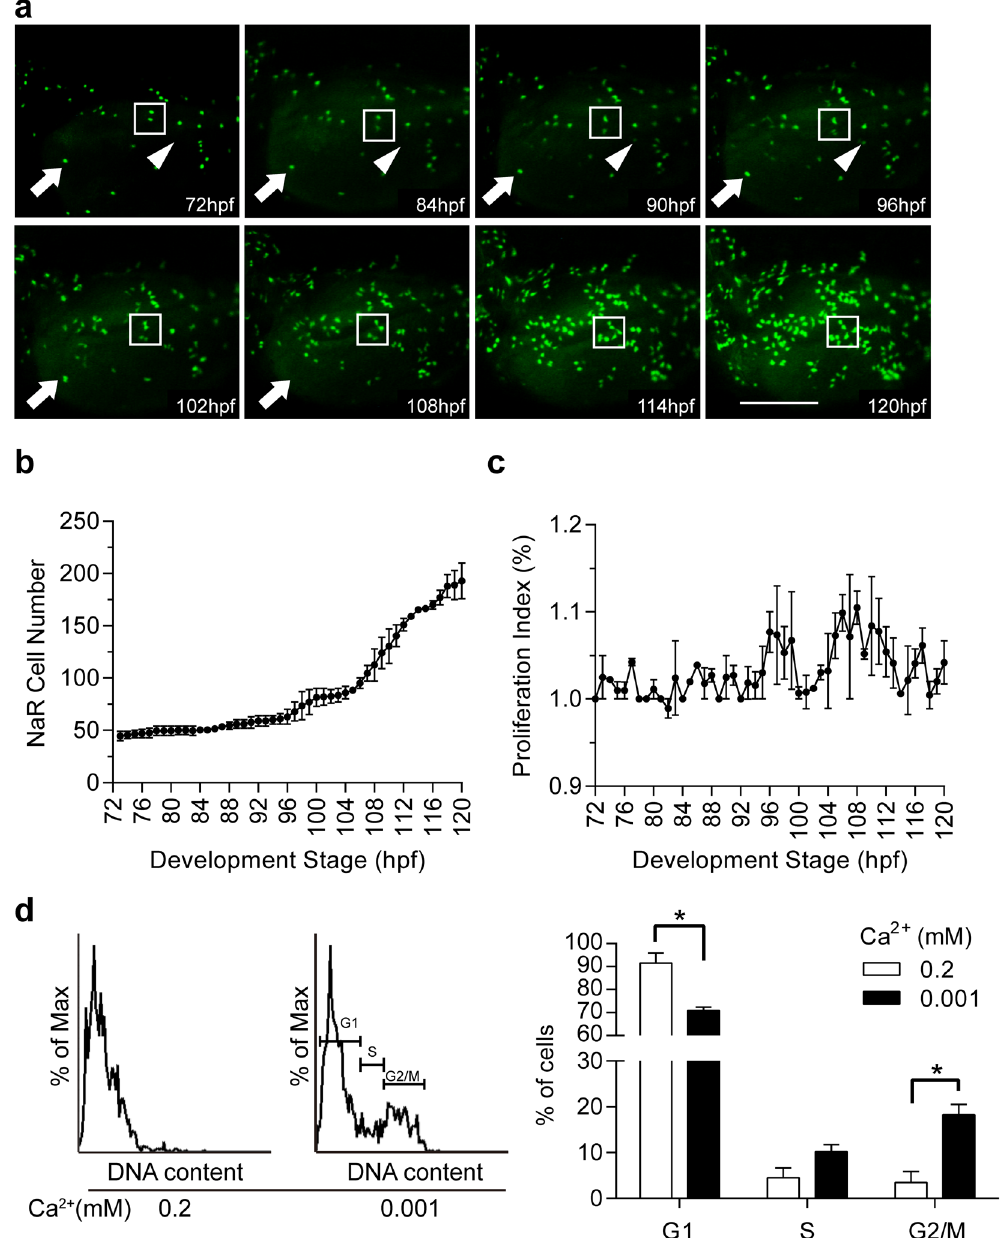
Figure 5. Dynamics of low [Ca 2 + ]-induced NaR cell proliferation. Tg ( igfbp5a : GFP ) larvae (72 hpf) were transferred to the embryo rearing solution containing 0.001 mM [Ca 2 + ]. Images were recorded from the same individual hourly and NaR cells numbers were determined. ( a ) Representative images at the indicated time points. The box shows two GFP-expressing NaR cells going through two divisions. The arrow indicates a NaR cell disappearing between 102–108 hpf. The arrowhead indicates the appearance of a new GFP-expressing cell around 86–90 hpf. ( b ) Average NaR cell number at the indicated time points. Values are mean ± SEM, n = 2. ( c ) NaR cell proliferation index at the indicated time periods. NaR cell proliferation index (%) = [(N t − N t − 1 )/N t − 1 ] * 100. N t is the NaR cell number at the time of interest. N t − 1 is the NaR cell number an hour earlier. ( d ) Cell cycle analysis results. Left panel is a representative cell cycle histogram. Quantitative results are shown in the right panel. Values shown are mean ± SEM, n = 3, * p <